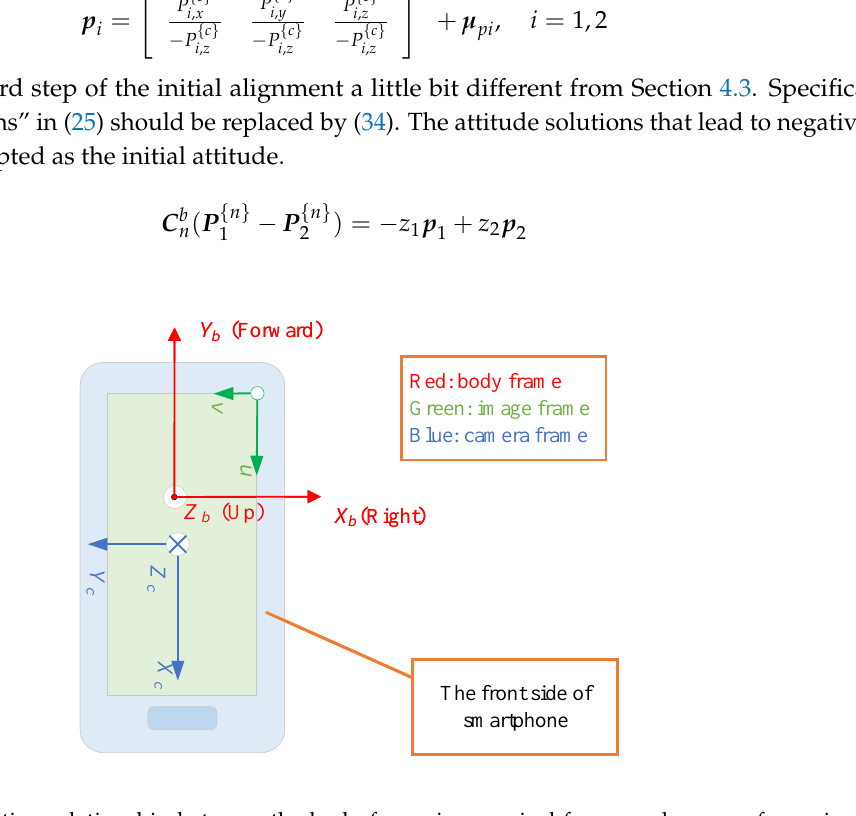
Figure 3. Direction relationship between the body frame image pixel frame and camera frame in experiment